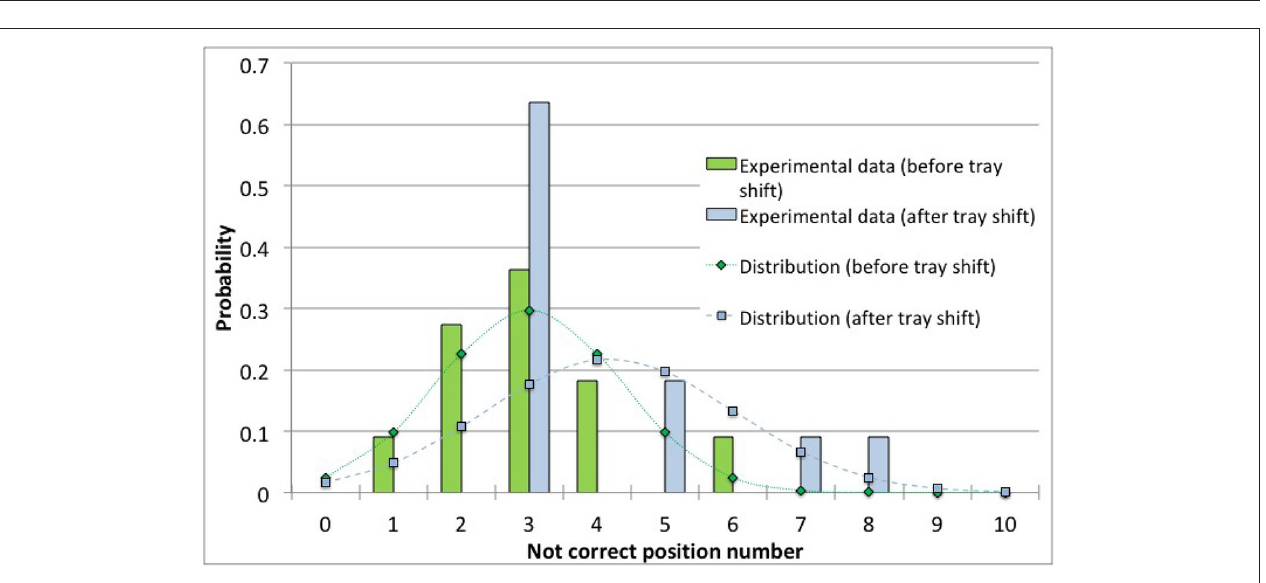
FIGURE 6 | Observed data and normal probability distribution representing the incorrect positioning of thermocouples for the 10R (24mm diameter) vials, before and after the shift of the tray.